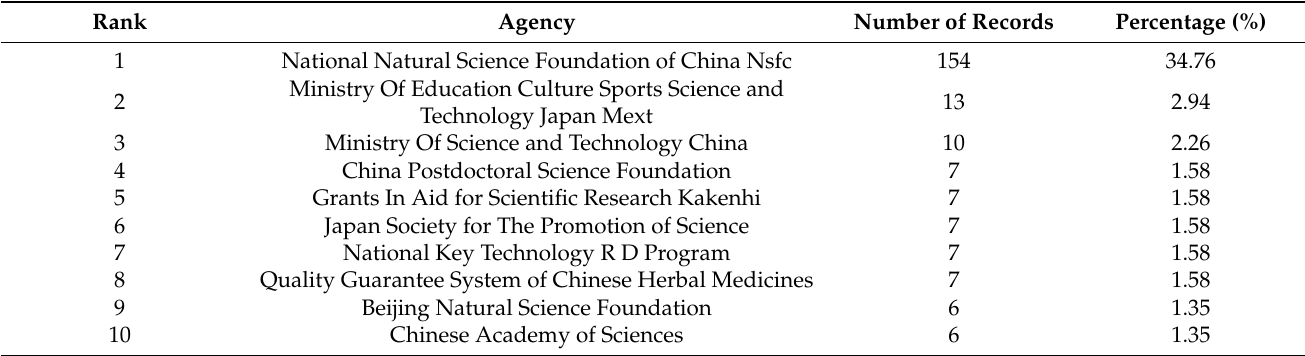
Figure 4. Institution collaboration network in Cistanche -related study. Node size represents the number of publications. Node color: average time to appear, color from white to red, time from 1980 to 2022. Purple circles indicate that these institutions have made significant contributions to the study. Table 3. Top 10 funding agencies.